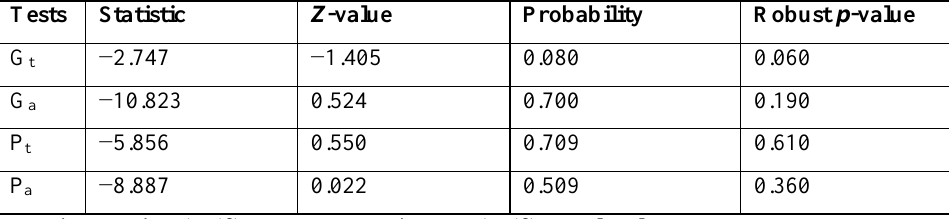
Table 4. Westerlund Co-integration Test